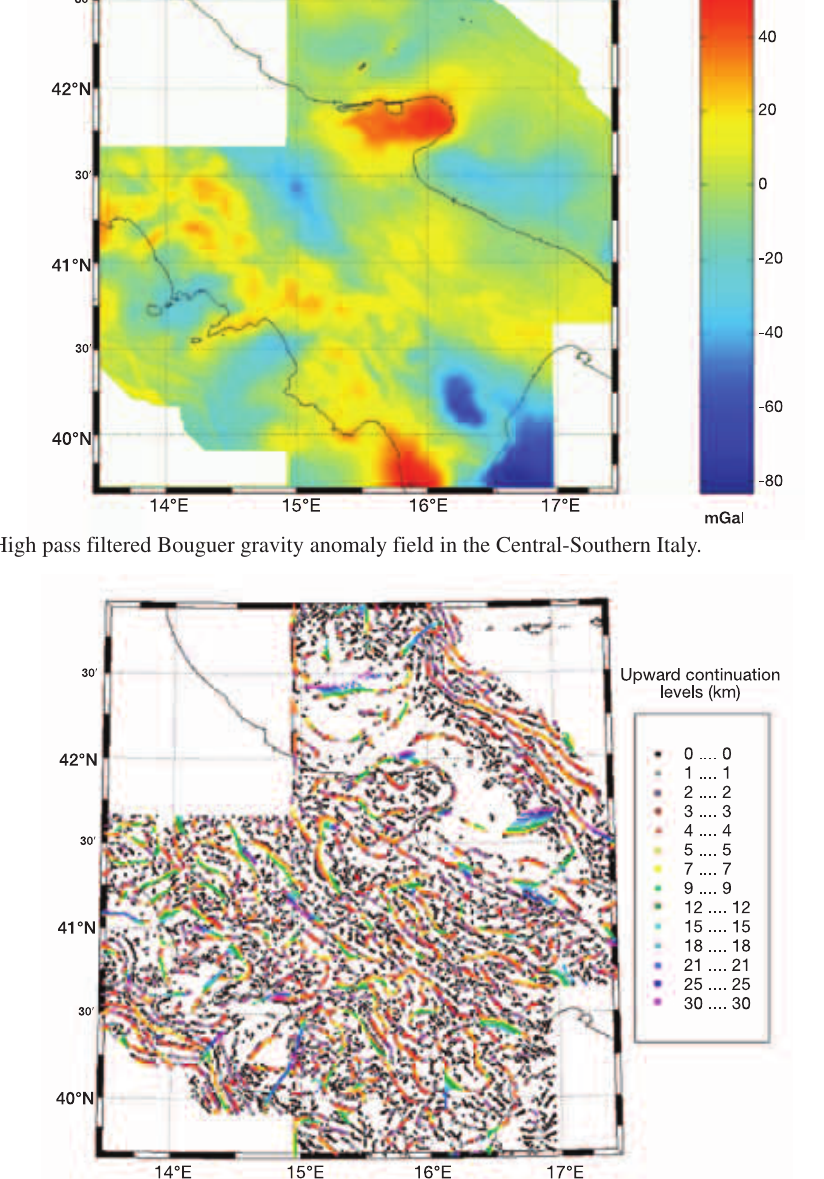
Fig. 9. Trends of local maxima of the horizontal gradient of the field shown in fig. 8, upward continued to several increasing levels (from 1 to 30